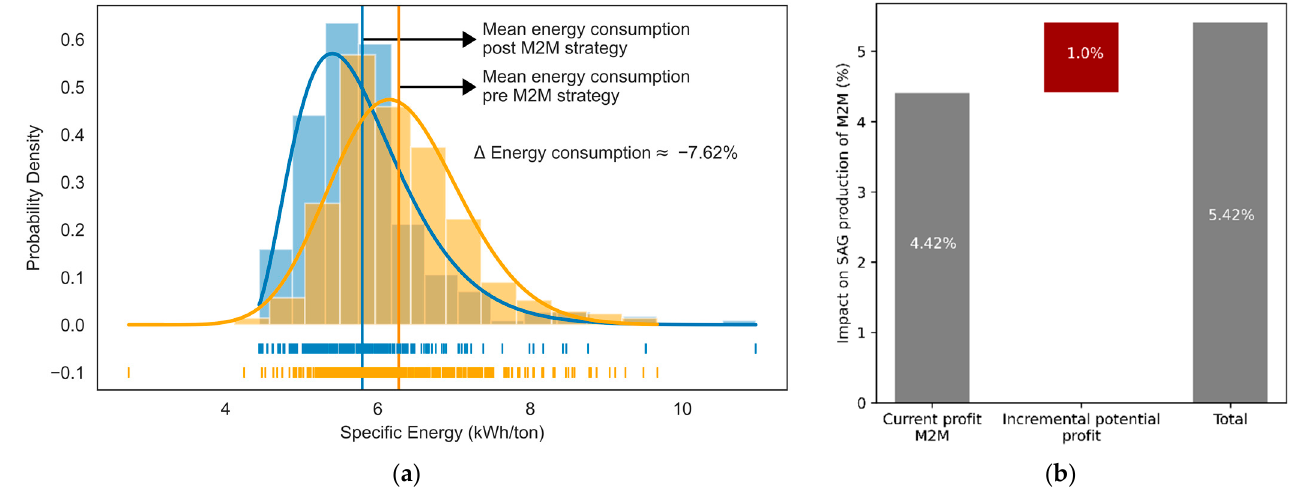
Figure 9. Specific energy consumption distributions ( a ) and the potential percentage impact on the production in TpH at the SAG mill ( b ).